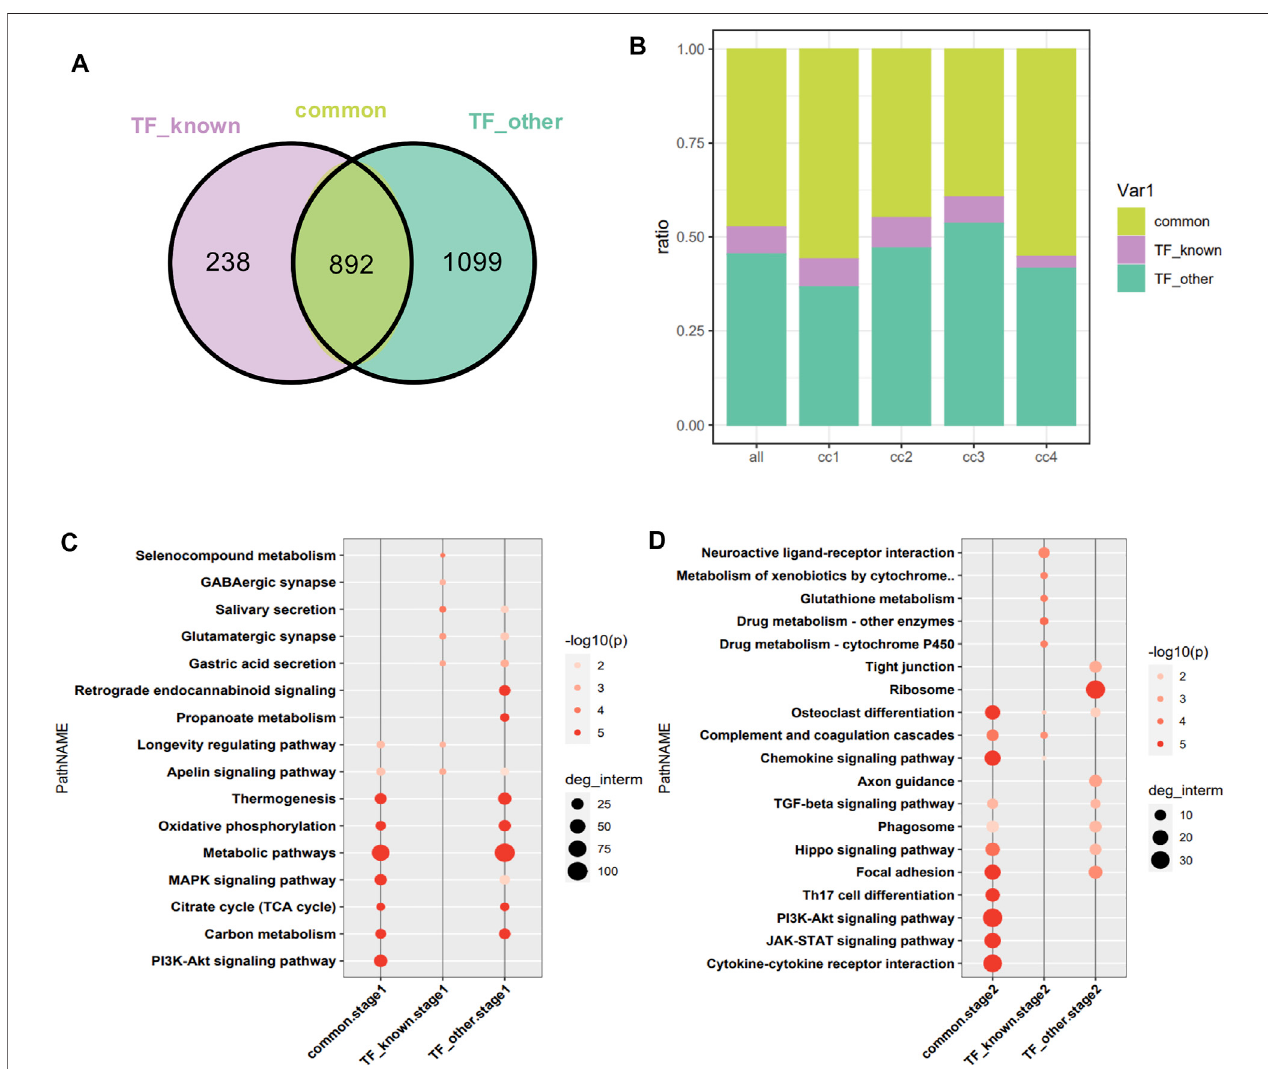
FIGURE 5 | Intersection of targets of DEGs encoding TFs related and unrelated to the pathophysiology of skeletal muscle. (A) Venn diagram analysis. TF_known: speci fi ctargetgenesofDEGsencodingTFsrelatedtothepathophysiologyofskeletalmuscle;TF_other:speci fi ctargetgenesofdifferentiallyexpressedTFsunrelatedto the pathophysiology of skeletal muscle. (B) Distribution of target genes in the four clusters. The horizontal axis represents the cluster to which the target gene belongs, with all as the reference. (C) Functional enrichment analysis of target genes at stage1. (D) Functional enrichment analysis of target genes at stage2.